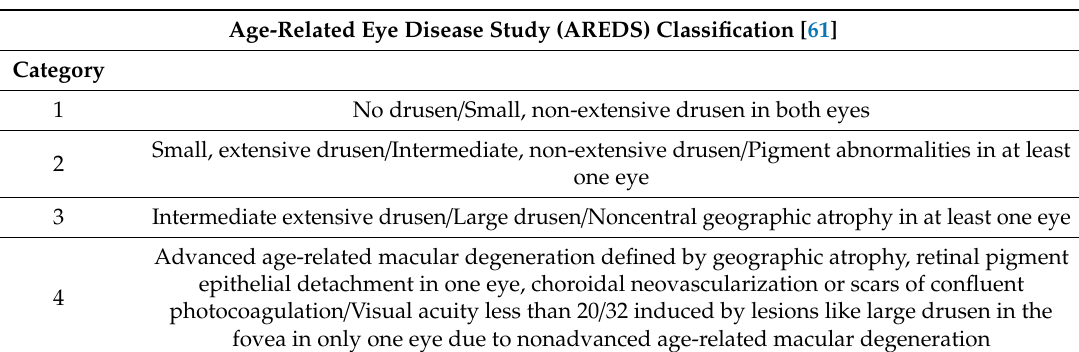
Table 3. AREDS categorization of